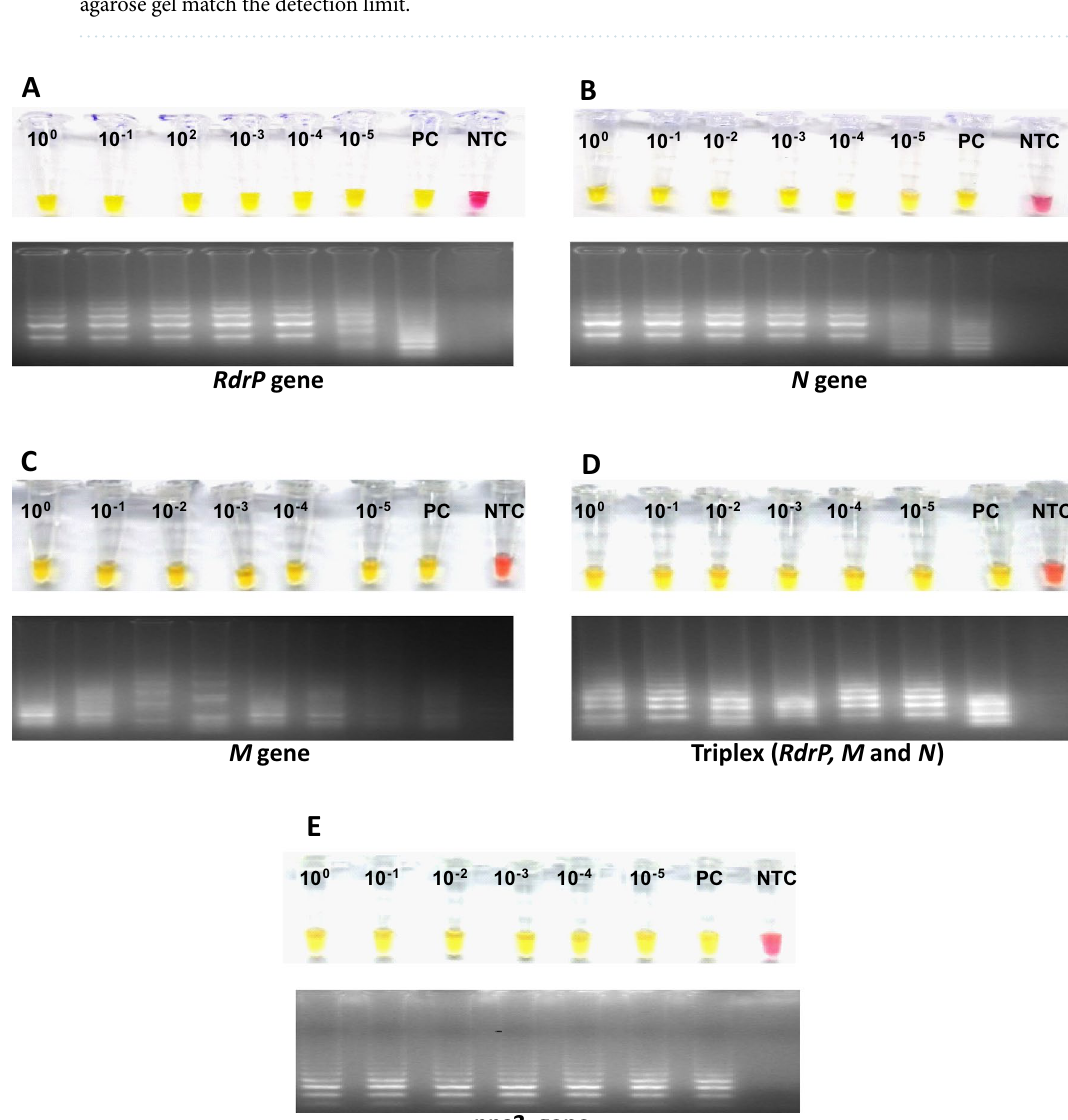
Figure 3. ( A ) Limit of detection (LoD) of sample 1 for the detection of the RdRp gene, ( B ) LoD of sample 1 for the detection of the N gene, ( C ) LoD of sample 1 for the detection of the M gene, ( D ) LoD of Sample 1 for the detection of Triplex ( RdRp , M , N genes), ( E ) LoD of sample 1 for the detection of the nsp3